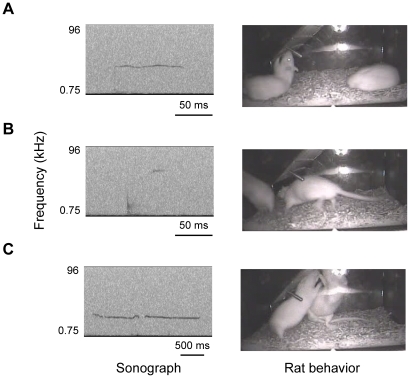
USV characteristics and rat behavior.Representative sonogram and image during (A) feeding (gnawing chow on the food hopper), (B) moving (galloping; right rat), and (C) fighting (mutual upright posture).